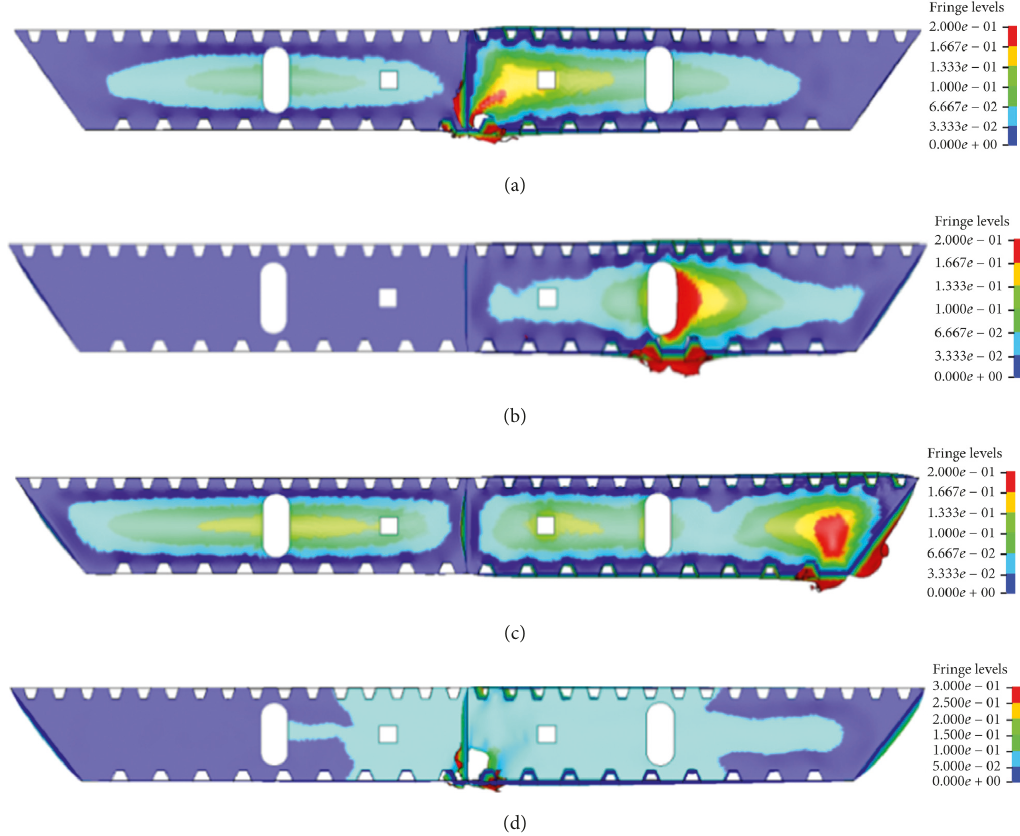
Figure 12: Fringe plot of the final displacement of the box girder (unit: m). (a) Position 1. (b) Position 2. (c) Position 3. (d) Position